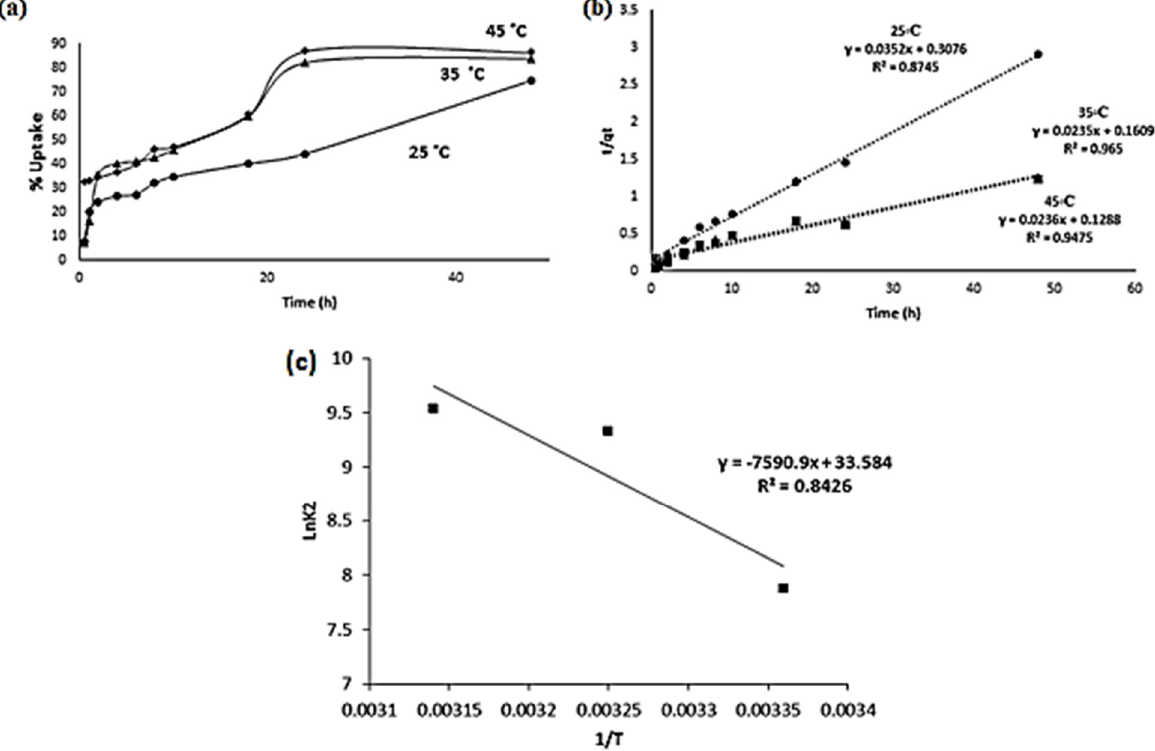
Figure 10. ( a ) Cd(II) uptake as a function of contact time, at pH = 4.00; ( b ) the pseudo-second-order sorption kinetics of Cd(II) as a function of contact time at pH = 4.00; and ( c ) the Arrhenius plots of Cd(II) at pH = 4.00.